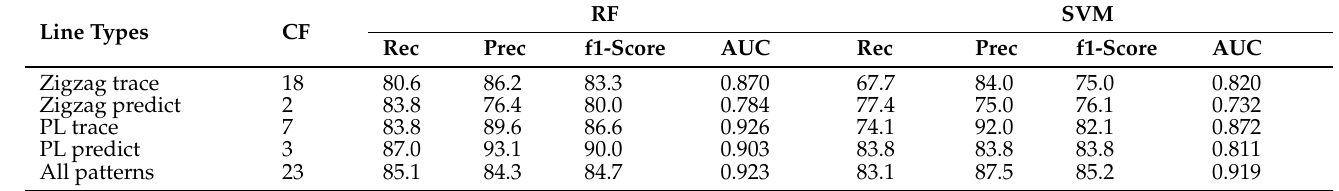
Table 11. Performance scores of RF and SVM for common features of handwritten pattern